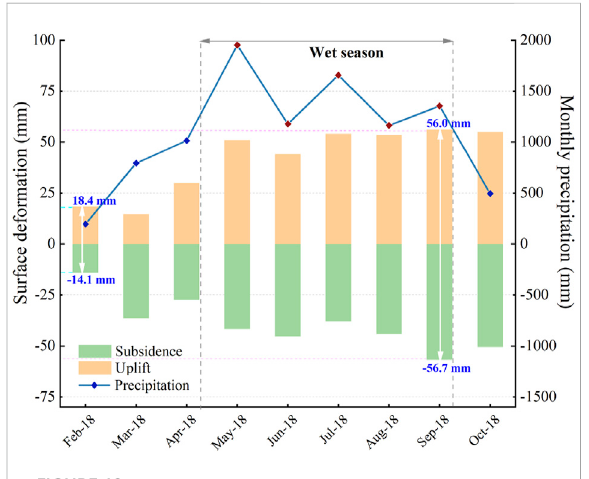
FIGURE 12 Monthly precipitation and surface deformation in the study area plotted against time in